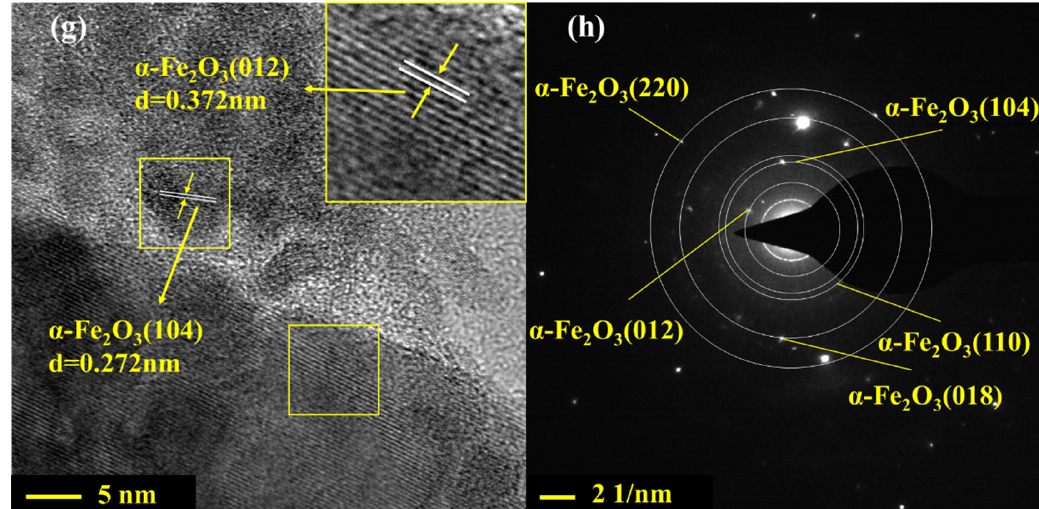
Figure 3. HRTEM and SAED images of α -Fe 2 O 3 (u) and La-doped α -Fe 2 O 3 (x) (x=4, 6, 8). ( a , b ) α -Fe 2 O 3 (u); ( c , d ) La-doped α -Fe 2 O 3 (4); ( e , f ) La-doped α -Fe 2 O 3 (6); ( g , h ) La-doped α -Fe 2 O 3 (8).